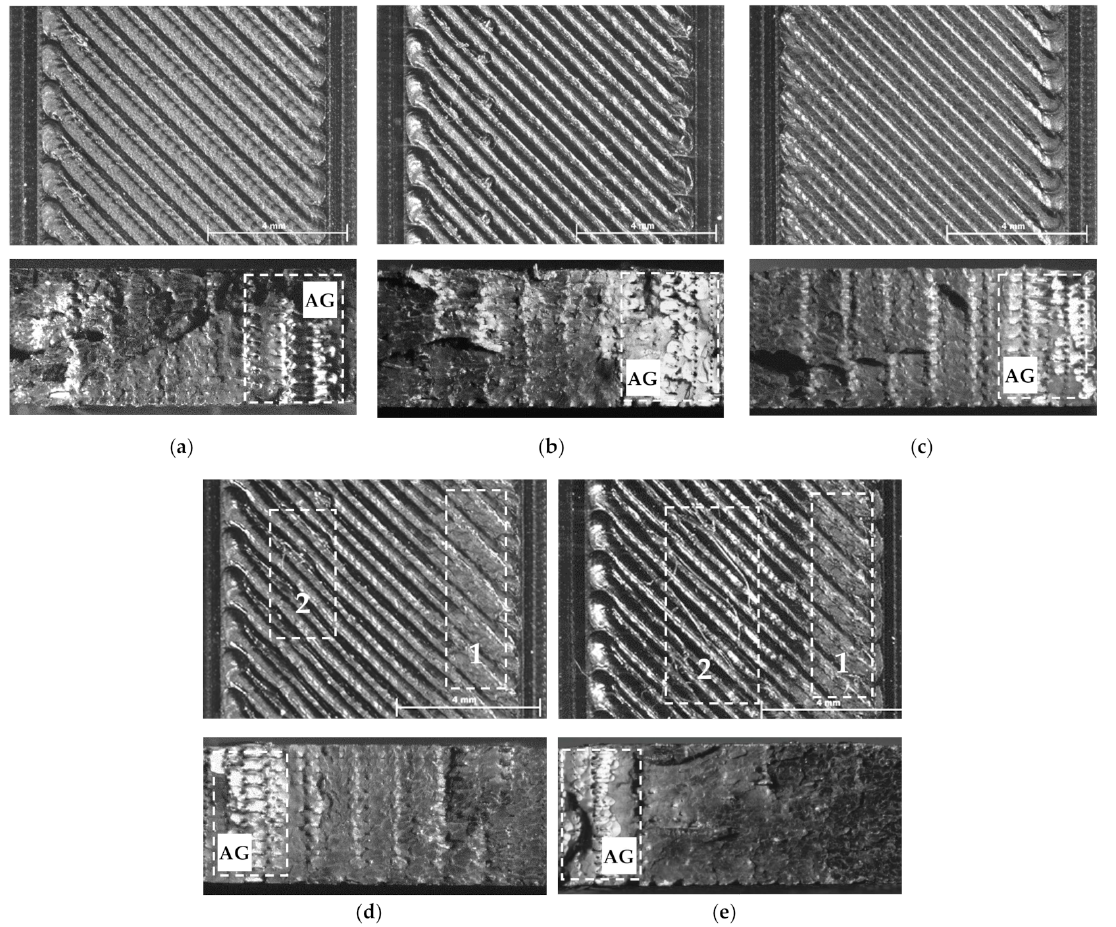
Figure 4. Top view (up) and fractured surface (down) of black PLA tensile specimens printed at ( a ) 200 ◦ C, ( b ) 210 ◦ C, ( c ) 220 ◦ C, ( d ) 230 ◦ C, ( e ) 240 ◦